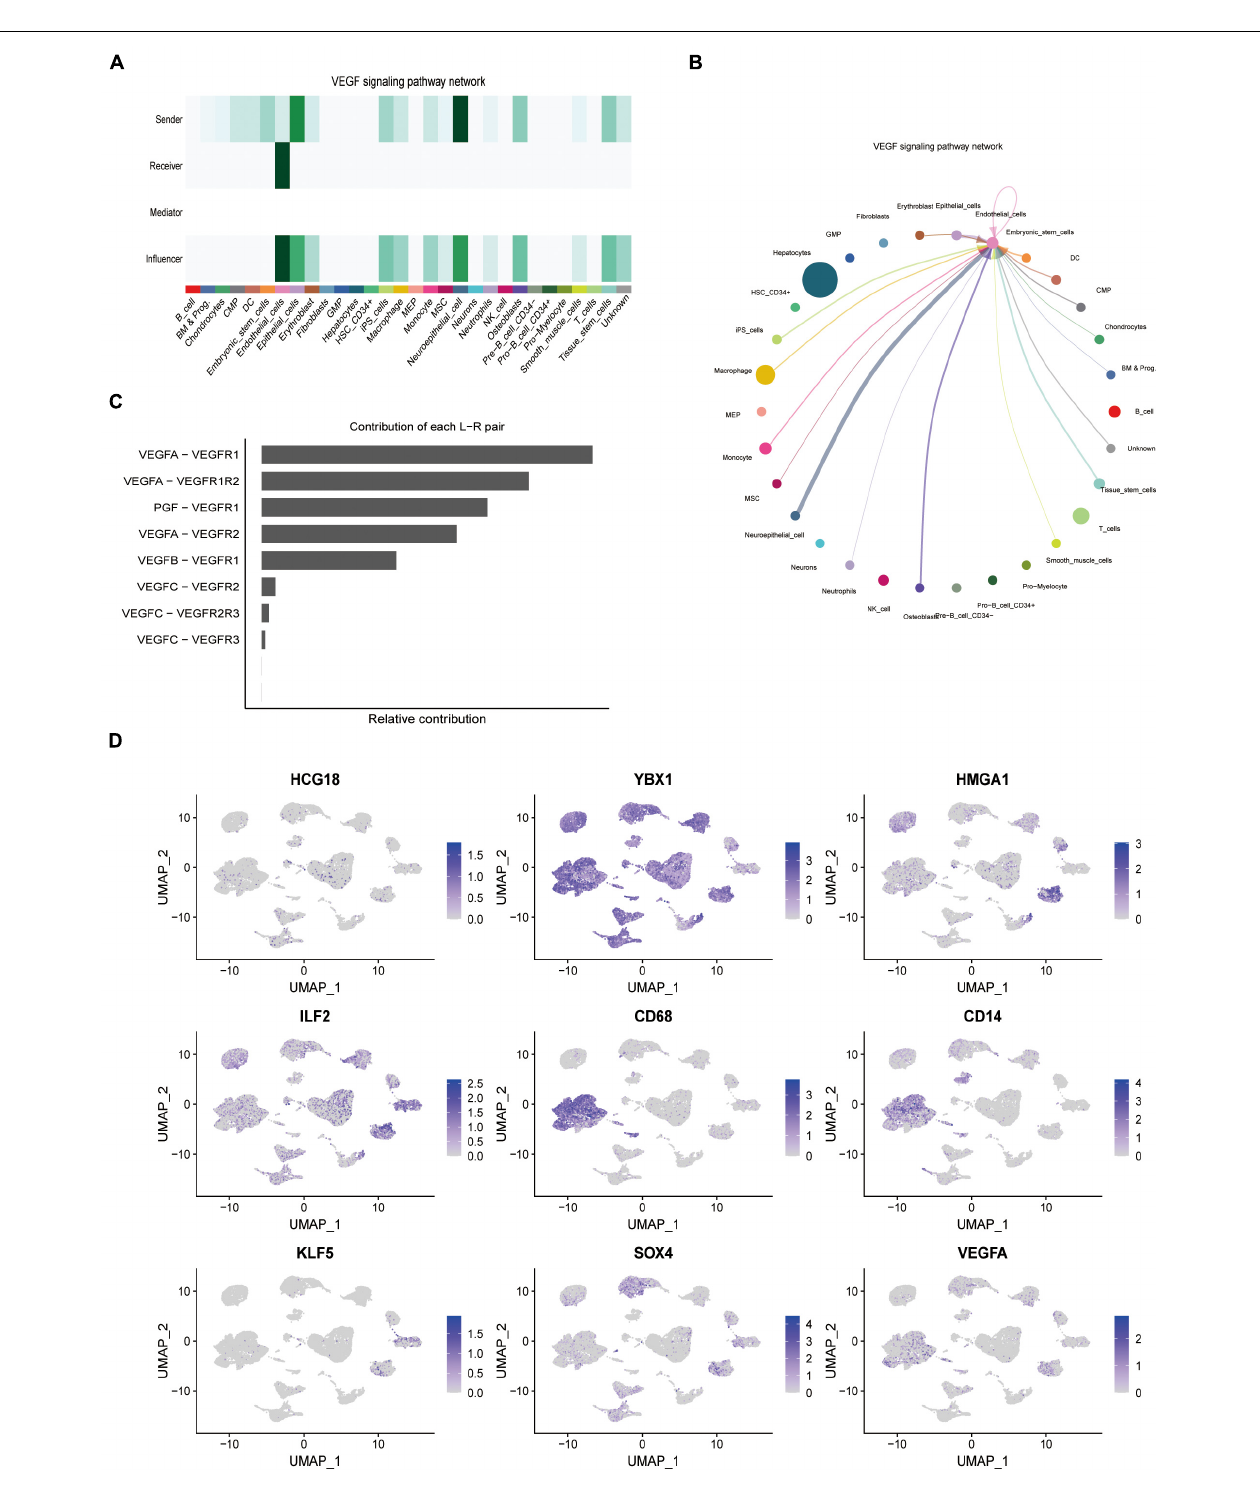
FIGURE 4 | HCG18 can regulate the expression of VEGF in tumors by mononuclear macrophages and stem cells in tumors. (A) The role of cells in the VEGF pathway; darker colors represent higher confidence intervals. (B) Intercellular communication in the VEGF pathway. Thicker lines between two cells represent greater intercellular communication. (C) Contributions of ligand and receptor pairs to intercellular communication in the VEGF pathway. Cell communication in the VEGF pathway is mainly mediated by VEGFA-VEGFR1. (D) Combined analysis of expression distribution and intercellular communication showed that HCG18, HMGA1, ILF2, and YBX1 were mainly mediated by mononuclear macrophages and tumor stem cell-like cells in vascular invasion. CD68 and CD14 were used as molecular markers of macrophages and monocytes, respectively. KLF5 and SOX4 were used as stem cell-like markers.